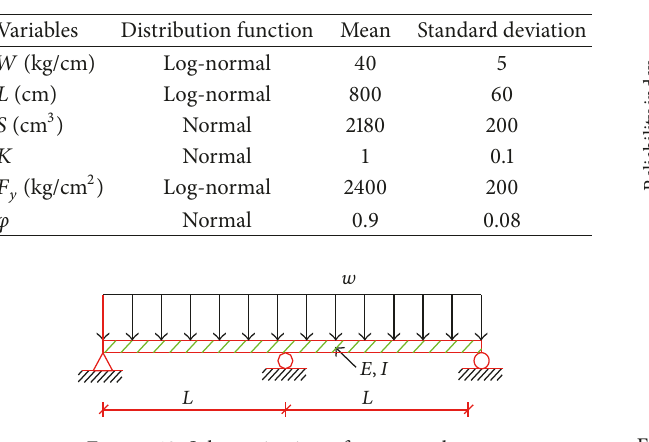
Figure 10: Schematic view of two-span beam. Figure 11: Convergence history of reliability method for two-span beam.